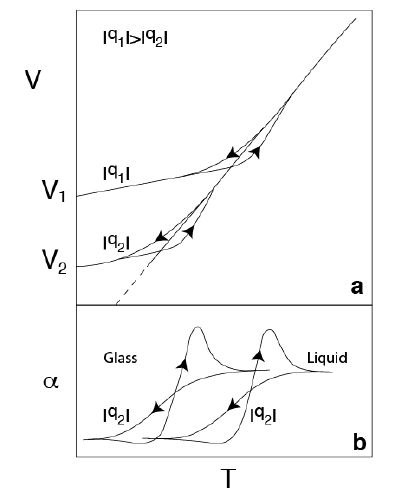
Figure 2: (a) Volume changes of a glass-forming melt on heating and cooling through the glass transition at two different rates q 1 and q 2 , causing the density of glass to decrease with faster quench. (b) Associated changes in thermal expansion coefficient, (cid:31) = 1/V dV/dT, which also differ on heating and cooling. This hysteresis is another illustration of the nonequilibrium nature of the glass